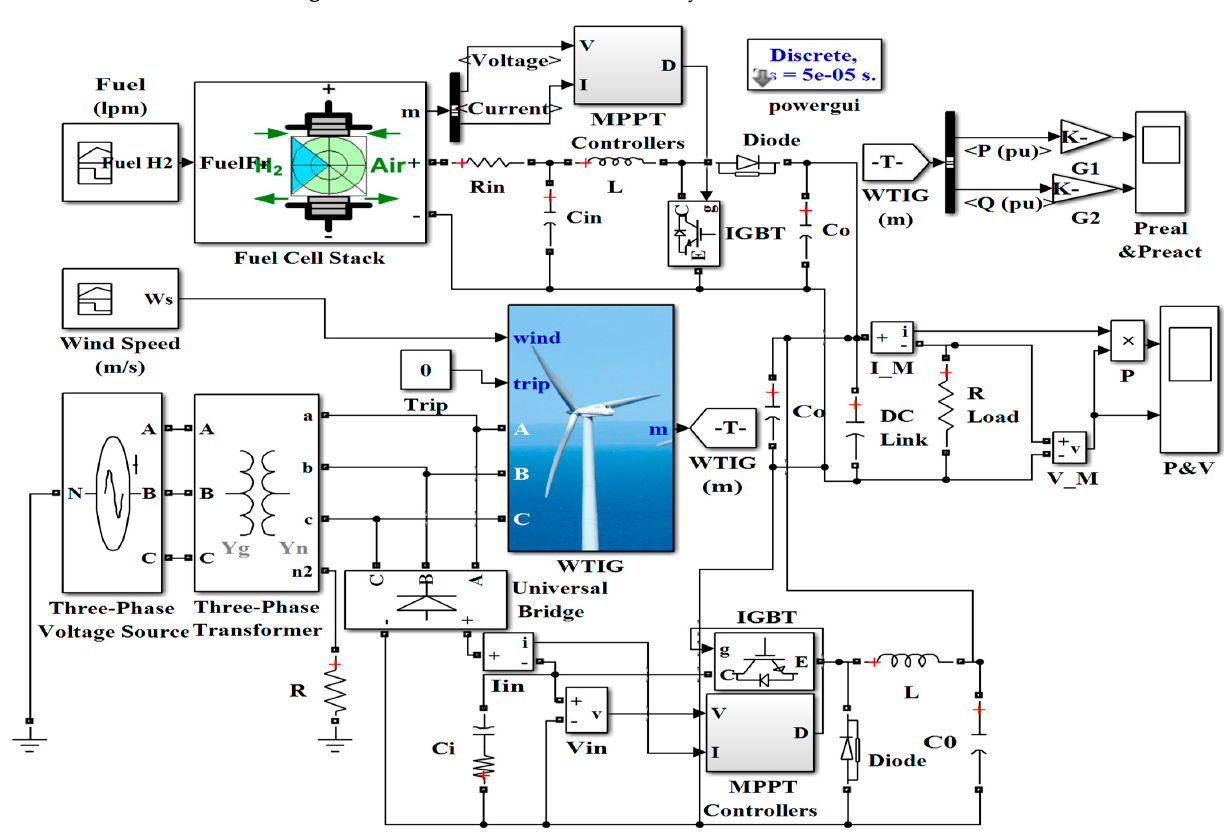
Figure 15. Simulation model of FC–PV system with MPPT controller.